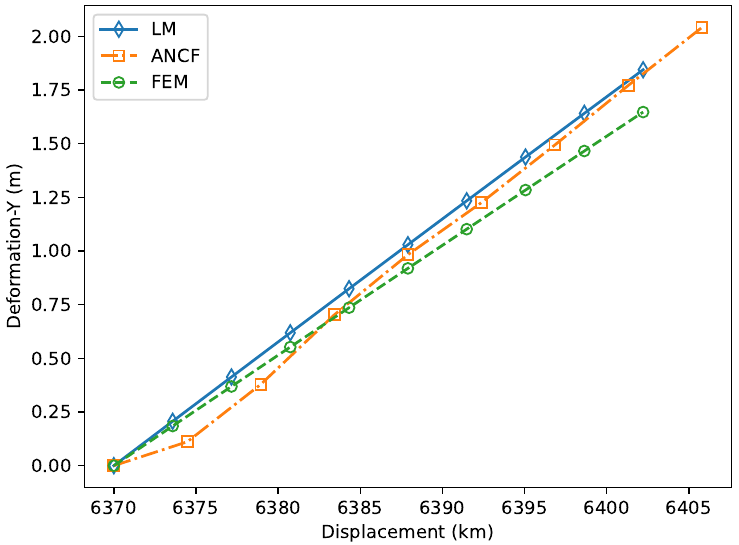
Figure 9. Deformation Y close to the